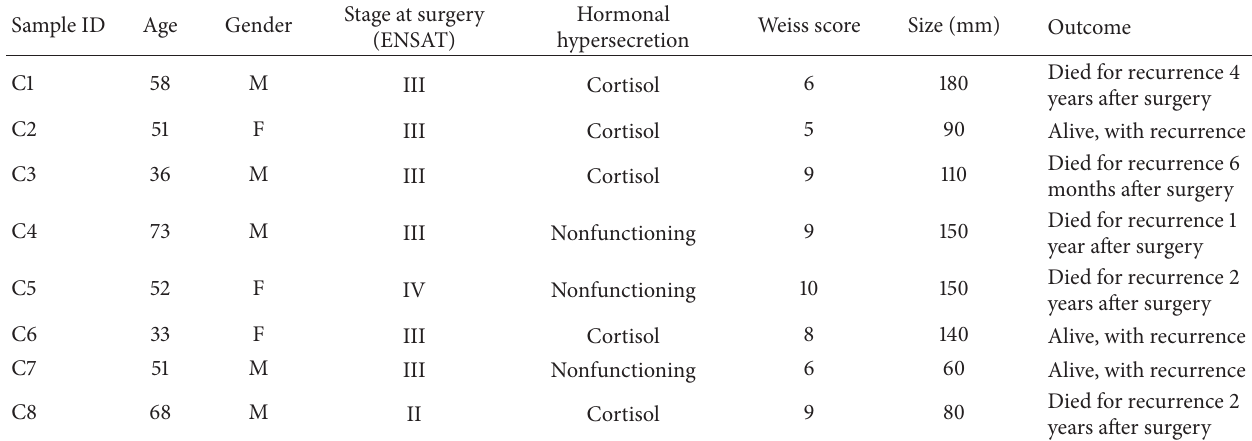
Table 1: Clinical and tumor characteristics of the ACC patients analyzed in this